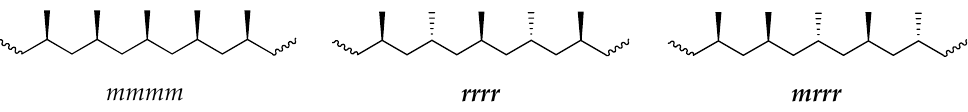
Scheme 1. Examples of regioregular polypropylene sequences.